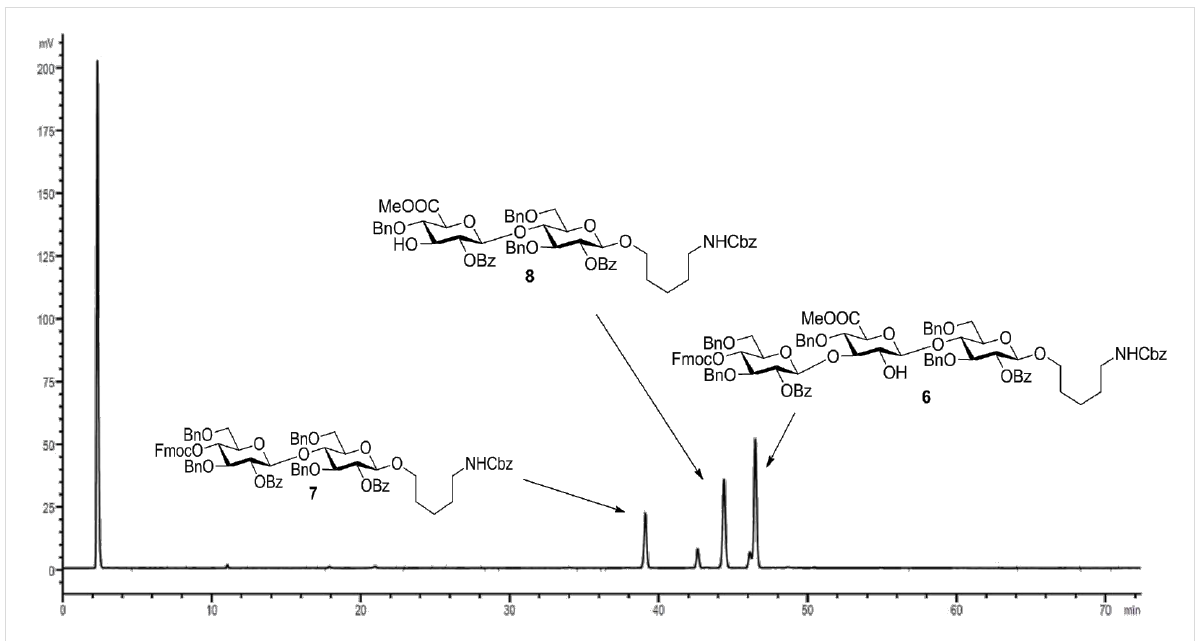
Figure 3: HPLC chromatogram of the crude products of the attempted AGA of SP3 trisaccharide 5 ; conditions: YMC Diol 300, H/EtOAc, 0% EtOAc (5 min) to 55% EtOAc (70 min), ELSD.